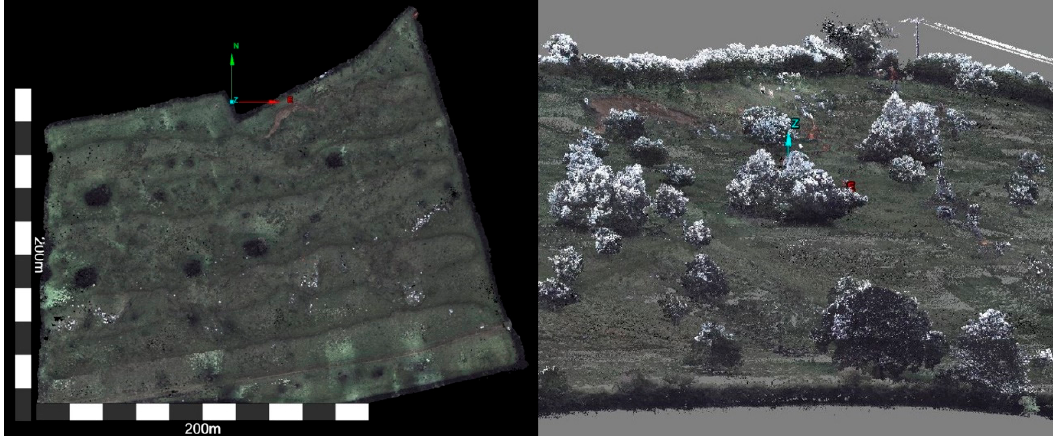
Figure 17. Digital terrain (DTM) and surface (DSM) models of the Hollin Hill landslide.